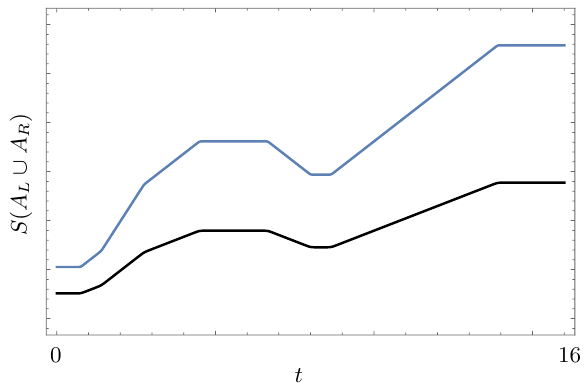
Figure 6 . Exact result for free fermion entropy of the disjoint union of two intervals, one in each copy of the thermofield double state. The plot displayed is for A L = [2 , 12 . 5] and A R = [3 . 5 , 15 . 3] and for β = 0 . 25 (blue) and β = 0 . 5 (black). The dip in the entropy is clearly